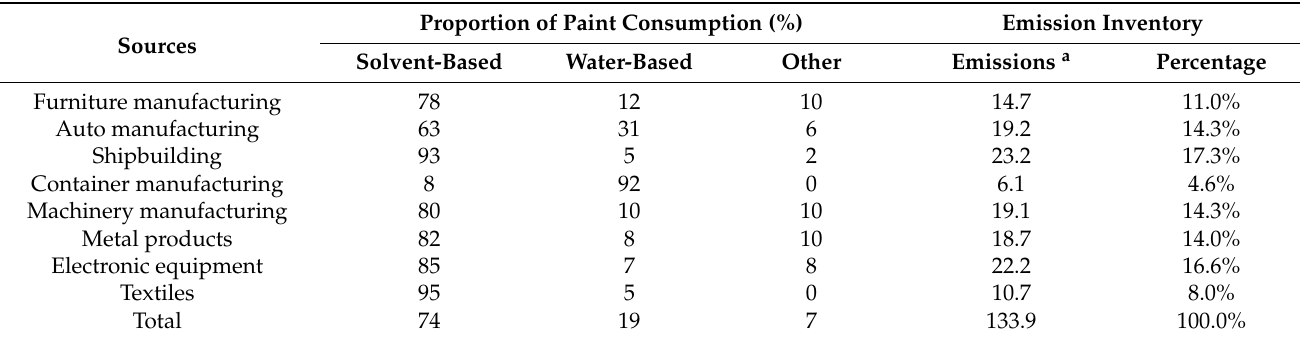
Table 5. The proportion of paint consumption and VOCs emissions of surface-coating industries in Jiangsu province in 2020.